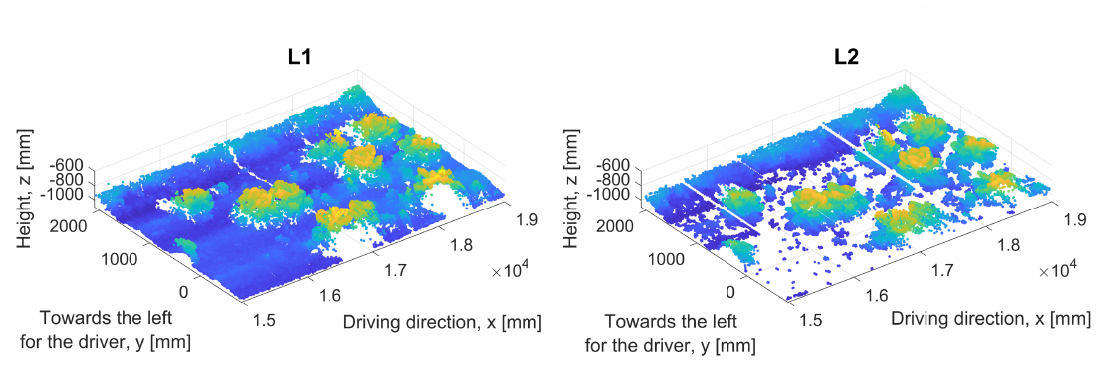
Figure 2. Example of the sensor output for the two lidars, including two areas of typical data losses recognisable by the white lines at a constant value of x . Furthermore, the inclined lidar has difficulties with detecting bare soil, which is clearly visible in the front-most corner of this sample area.